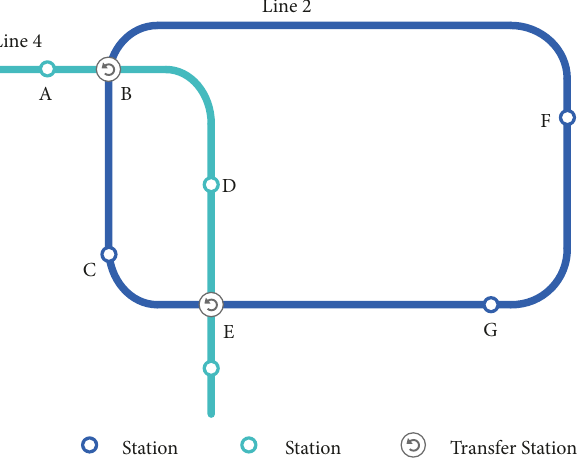
Figure 1: URT network